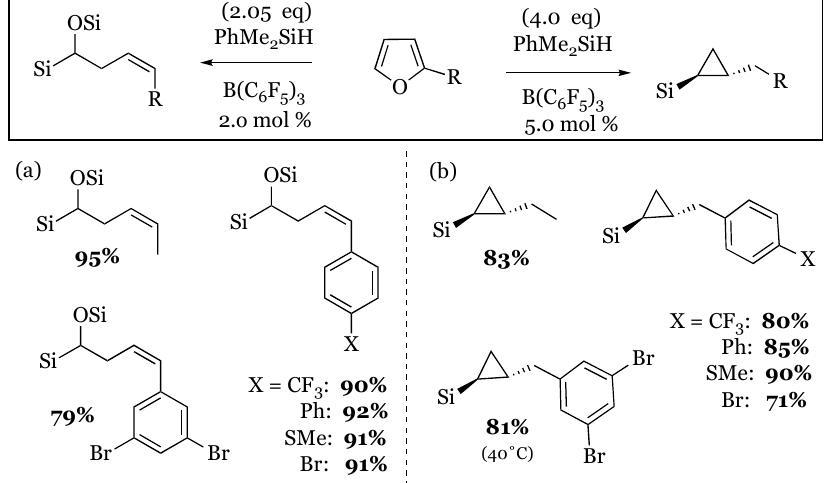
Figure 21. Conversion of furans to: ( a ) α -siloxy-( Z )-alkenylsilanes; ( b ) alkylcyclopropylsilanes.